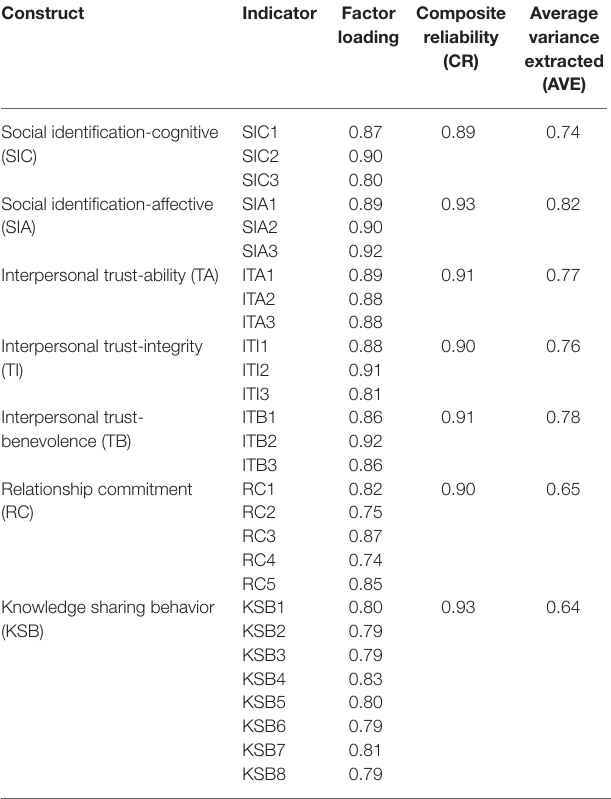
TABLE 1 | Results of factor loading, CR, and AVE. Construct